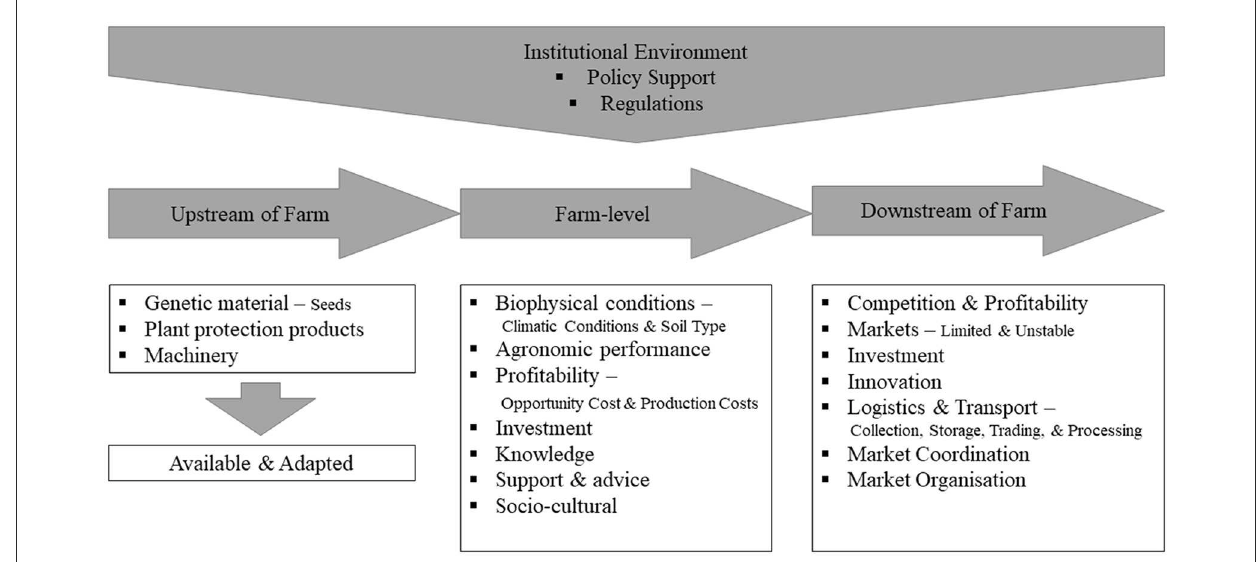
FIGURE1 Conceptual framework of barriers to crop diversification based on a preliminary review of agricultural innovation literature and a review of literature on barriers to crop diversification (Prager and Posthumus, 2010; Carlisle, 2016; Wreford et al., 2017; Mills et al., 2020; Morel et al.,